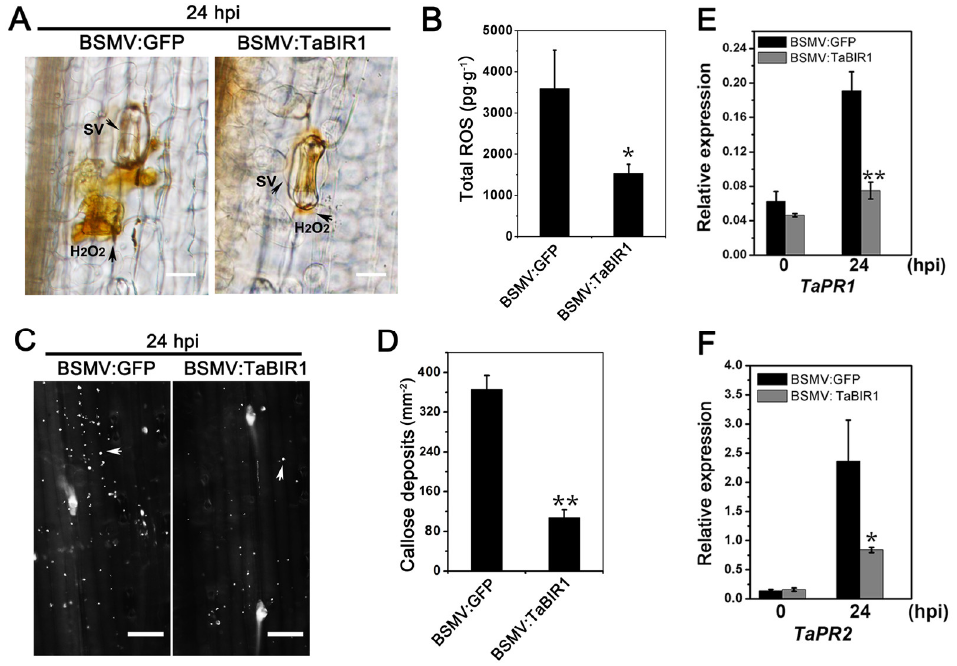
Figure 4. Impaired defense responses in TaBIR1 -silenced plants. ( A ) Observation of DAB stained H 2 O 2 in Pst infected TaBIR1 -silenced plants at 24 hpi. Bars, 20 µm. ( B ) Determination of ROS production in TaBIR1 -silenced plants. The fourth leaves of wheat seedings inoculated with BSMV: GFP and BSMV: TaBIR1 were collected at 24 hpi for ROS content detection using HRP-labeled method. ( C ) Reduced callose deposition in TaBIR1 -silenced plants. The fourth leaves of wheat seedings inoculated with BSMV: GFP and BSMV: TaBIR1 were collected for aniline blue staining. White arrows shows the callose deposites. Bars, 50 µm. ( D ) Quantification of the number of callose deposits per mm 2 . Data are mean ± standard errors (n = 30) from three independent biological replicates. ** p < 0.01 ( E , F ) Expression profile of pathogenesis related genes TaPR1 and TaPR2 in TaBIR1 -silenced plants using qRT-PCR. Wheat TaEF-1α was used as the internal reference gene. * p < 0.05, ** p < 0.01. Three biological replicates were performed.